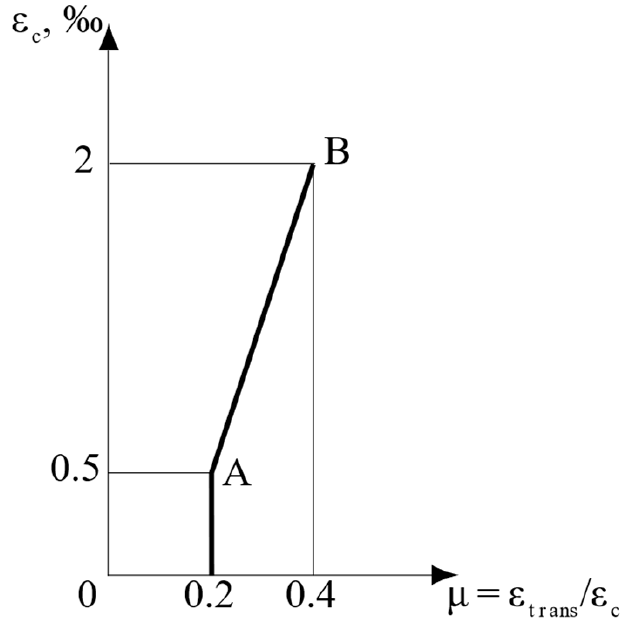
Figure 8. Theoretical relationship between µ = ε trans / ε c and longitudinal deformation ε c . A: com-